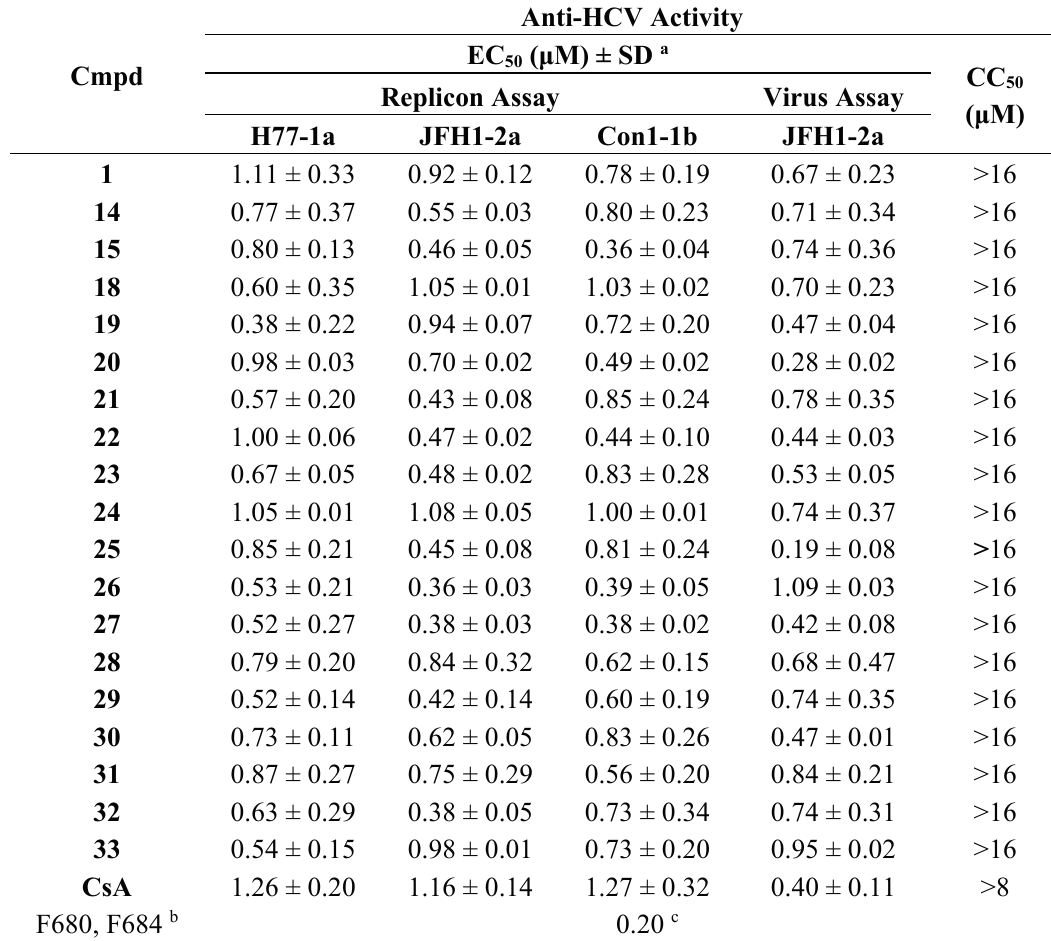
Table 4. The anti-HCV activities of compounds 14 , 15 , 18 – 33